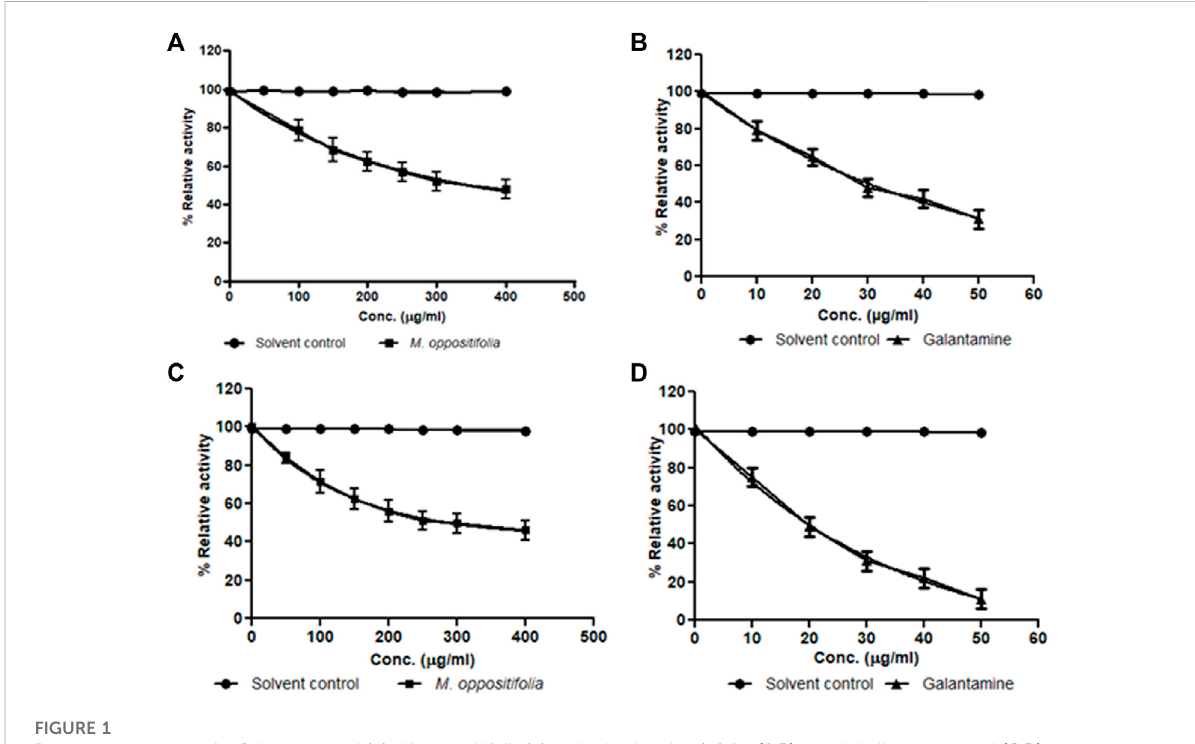
FIGURE 1 Dose-response curve for Solvent control ( butyrylcholinesterase enzyme inhibition.